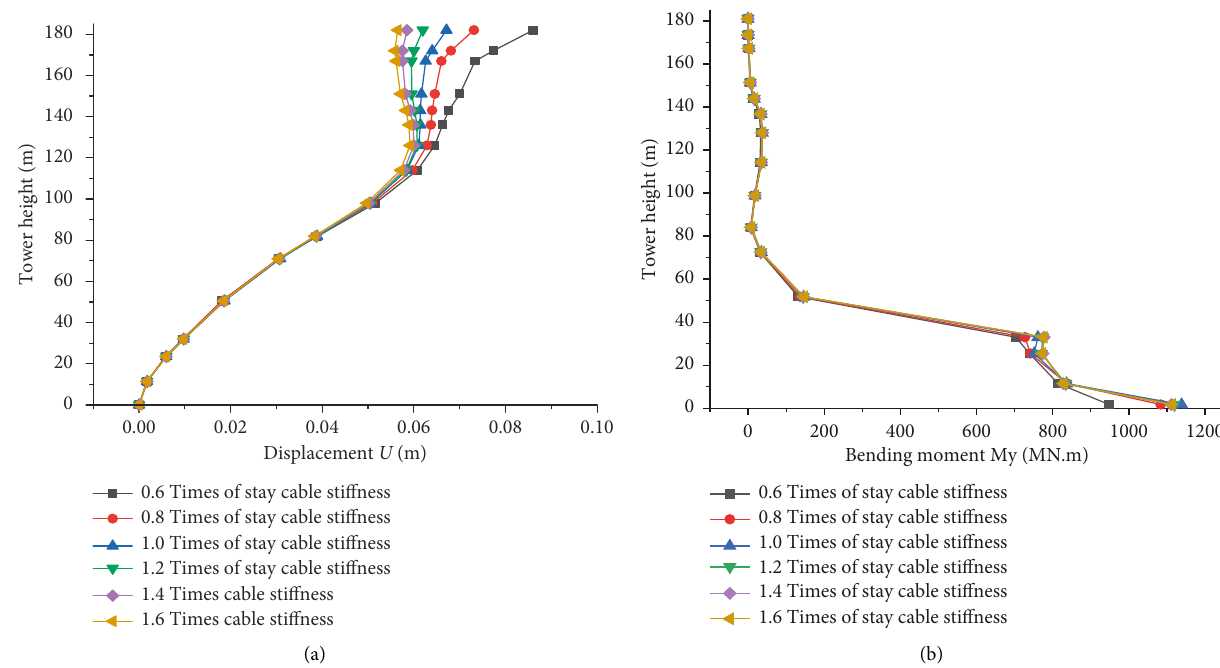
Figure 5: Distribution of maximum displacement U and maximum bending moment My along with the tower height for bridges with different multiples of cable stiffness under earthquake action. (a) Distribution of the maximum values of the tower displacement and (b) distribution of the maximum values of the tower bending moment.